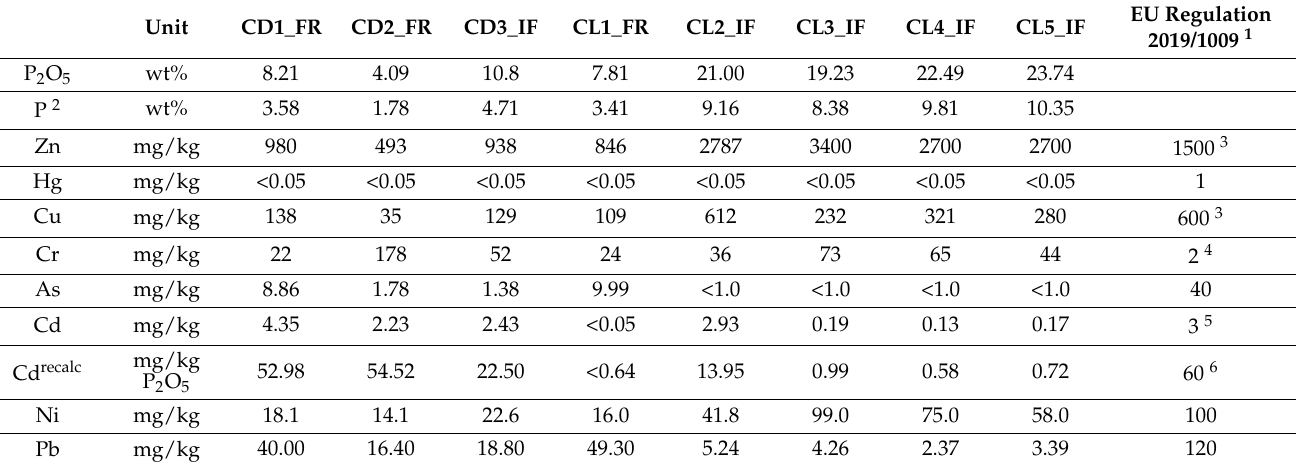
Table 4. Concentration of selected elements in ash samples (dry basis) confronted with current UE